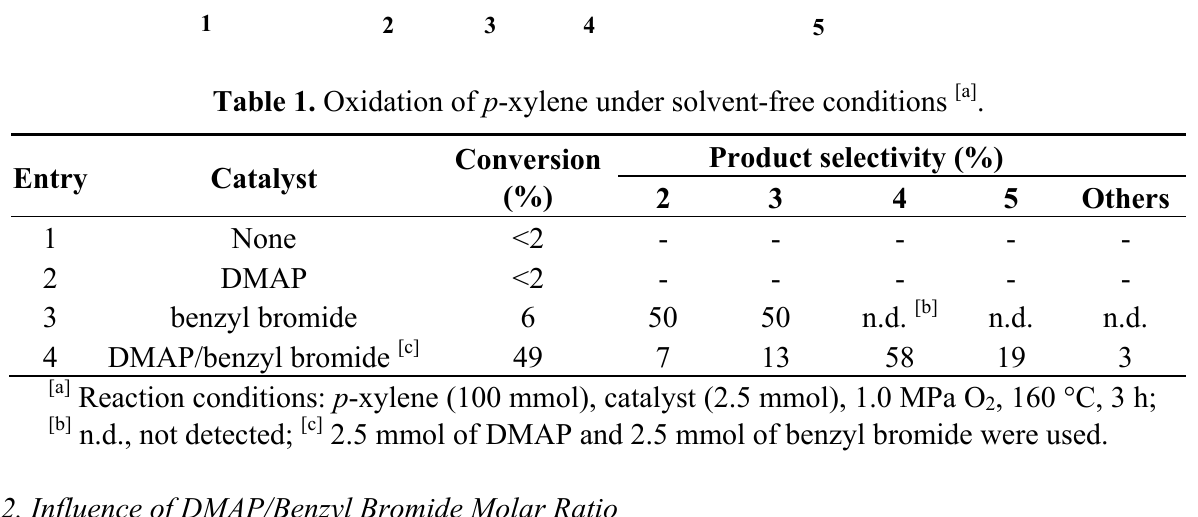
of p -xylene, 2.5 mmol of benzyl bromide, 160 °C, 1.0 MPa O